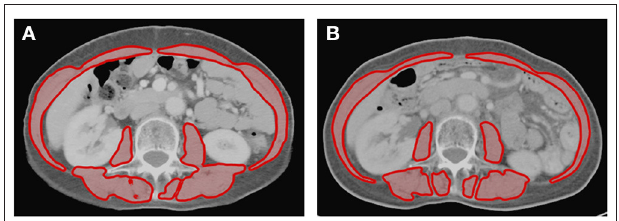
FIGURE 1 | Axial cross-sectional areas of skeletal muscle (red) on CT images at the L3 vertebral level (A) before and (B) after treatment in one patient. The skeletal muscle areas of this patient were 81.6 and 77.3 cm 2 before and after treatment, respectively. This patient had a reduction of 5.3% of skeletal muscle after